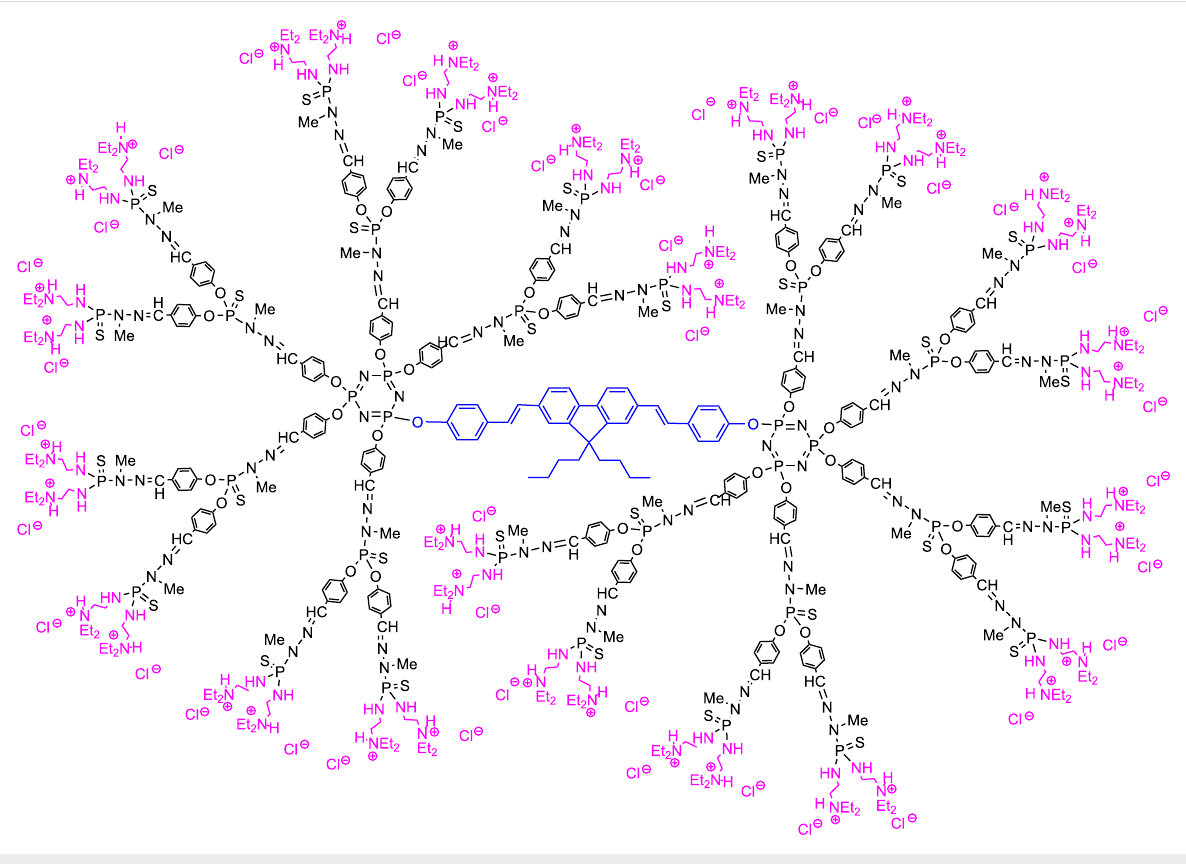
Figure 9: Dumbbell-like dendrimer used for two-photon imaging of the blood vessels of a living rat olfactory bulb.